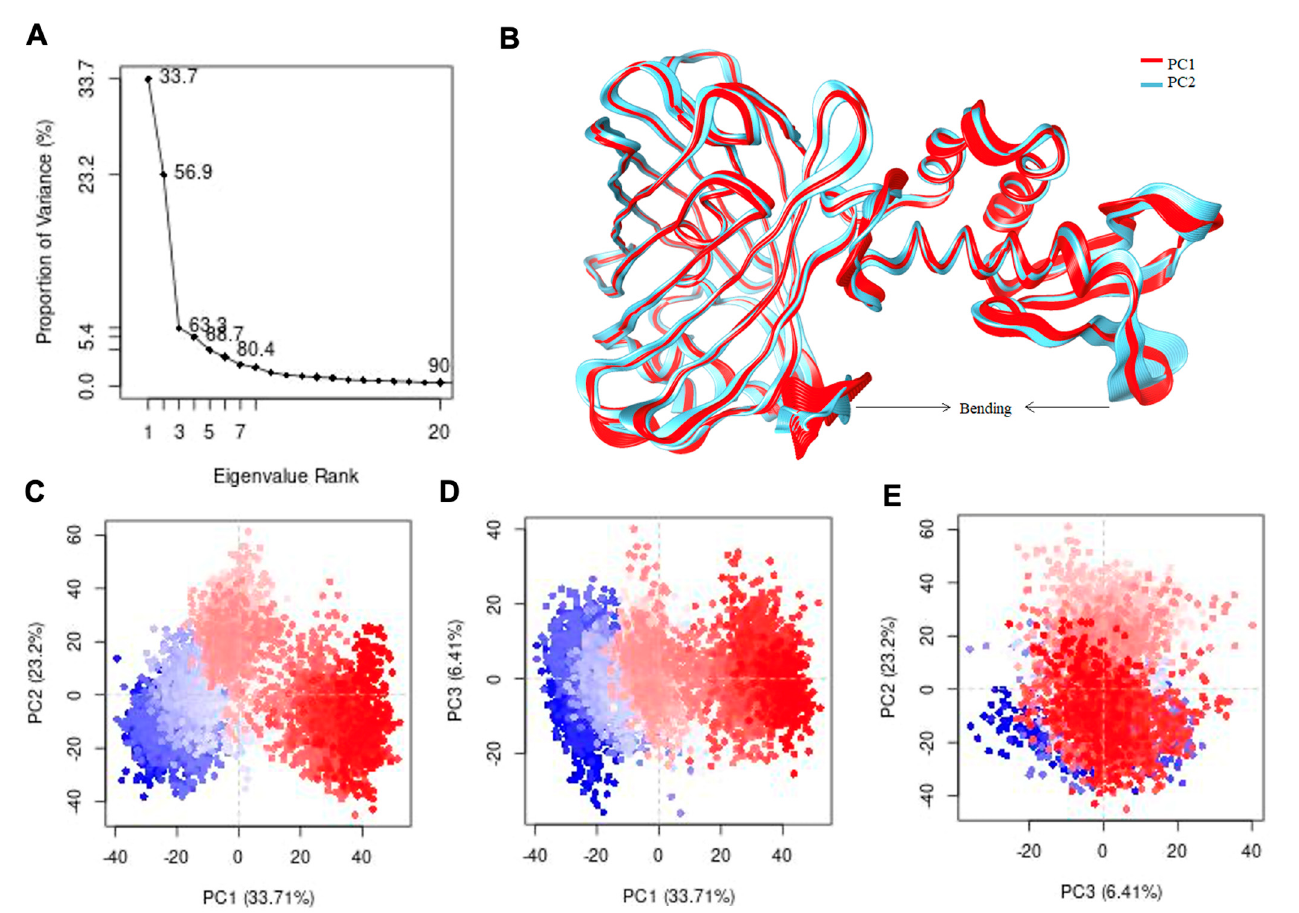
Figure 6. ( A ) Depiction of the proportion of variance (%) against its Eigenvalue rank. ( B ) Visualization of dynamics of PC1 for depiction of the fluctuating regions. ( C – E ) Projection of the trajectory formed by the first three principal component analyses based on k-means values.